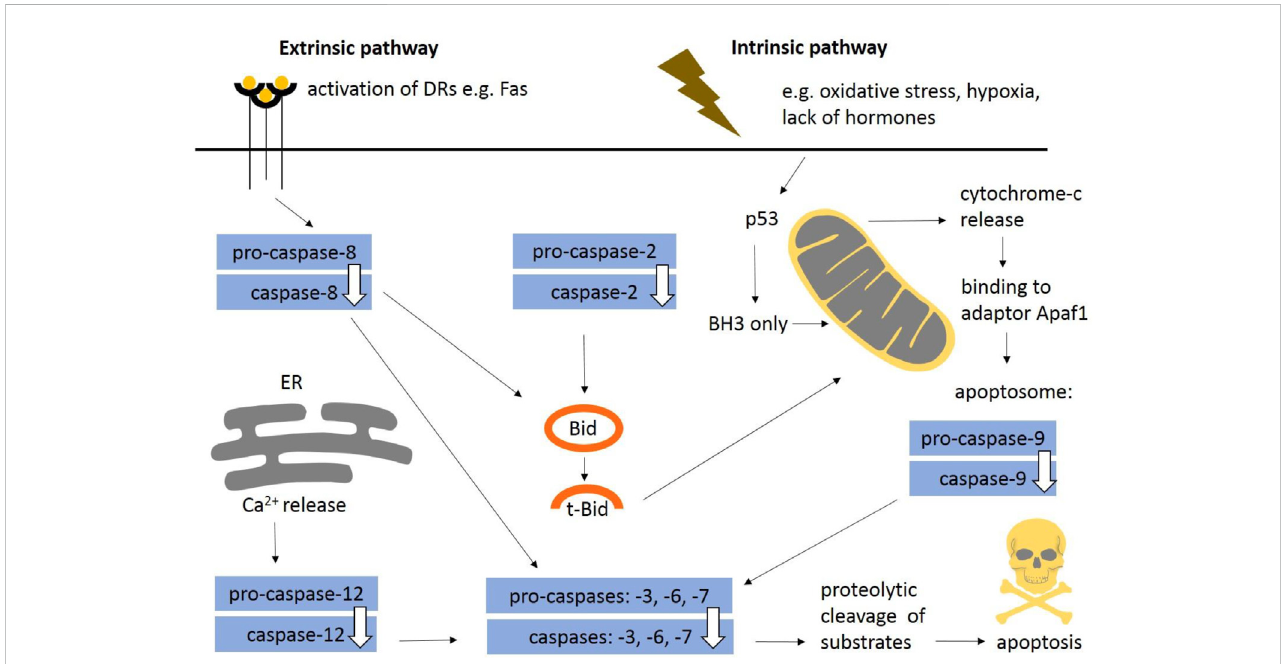
General schema of apoptotic engagement of caspases. The extrinsic pathway is induced via death receptors (e.g., Fas). Stimulation of death receptors results in activation of initiator caspase-8. The intrinsic pathway is usually initiated in a cell-autonomous manner (e.g., DNA damage, accumulation of unfolded/misfolded proteins, lack of pro survival factors such as cytokines). Internal signals regulate mitochondrial outer membrane permeabilisation and formation of apoptosome leading to activation of initiator caspase-9. Caspase-12 contributes to Ca 2+ dependent apoptosis. Caspase-2 belongs to initiators. Both pathways aim to activate caspase-3, the central executor caspase, or other executors caspase-6, -7. The extrinsic and intrinsic pathways are often interconnected (e.g., Bid/tBid). Apoptosis is modulated by pro-survival and pro-apoptotic signals (BH3-only proteins). DRs, death receptors; ER, endoplasmic